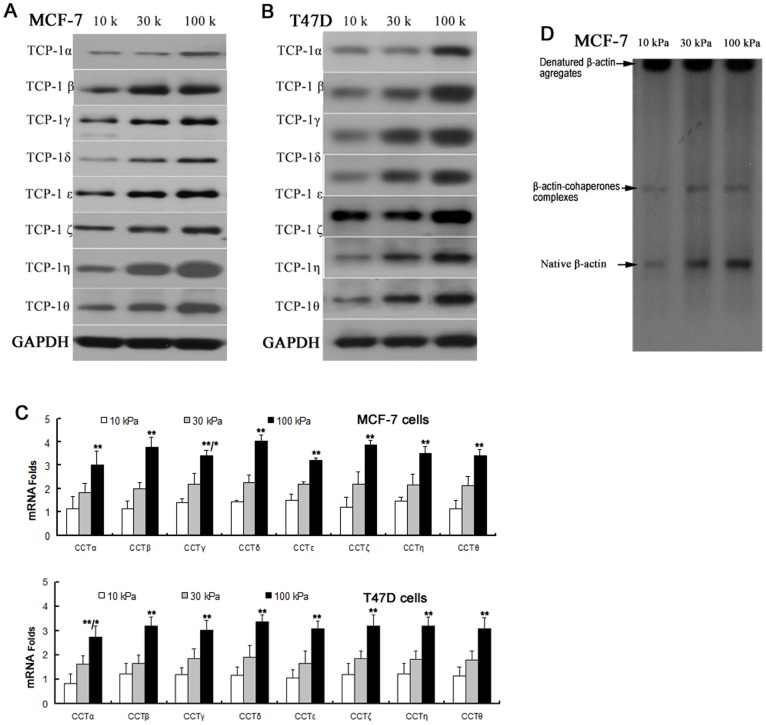
Effects of substrate rigidity on the mRNA and protein expression levels of CCTs, and changes in CCT folding activity.(A) Western Blot analysis showing changes in the protein expression of CTT/TRiC in the breast cancer cell line MCF-7 cultured on 10-kPa, 30-kPa, and 100-kPa substrates, respectively. (B) Western Blot showing changes in the protein expression of CT/TRiC in the breast cancer cells T47D cultured on 10, 30, and 100-kPa substrates. (C) Real-time RT-PCR showing changes in the mRNA expression of CTTs in MCF-7 and T47D breast cancer cells cultured on 10, 30, and 100 kPa substrates, **P<0.01, compared with 10 or 30 kPa substrates. (D) CCTs folding activity in MCF-7 cell extracts grown on different substrates (10, 30, and 100 kPa).